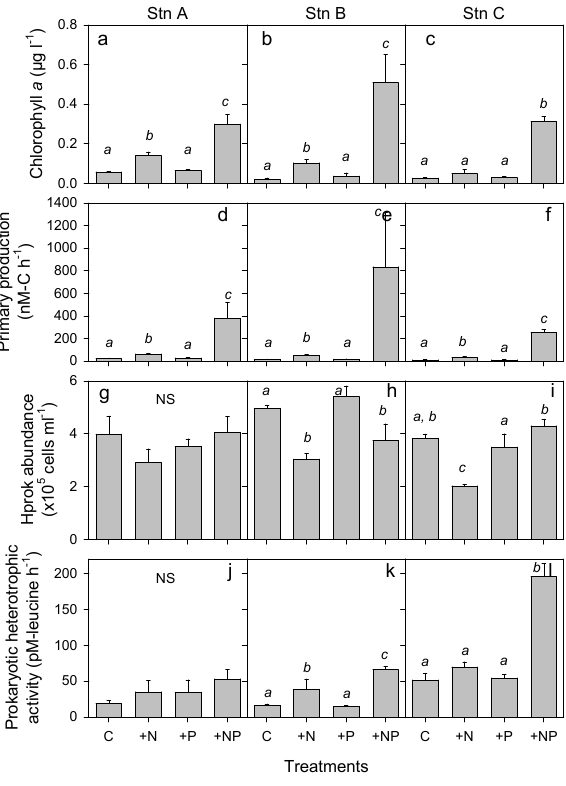
Fig. 4. Comparison of responses of chlorophyll- a (µgl − 1 ) ( a, b, c ), primary production (nM-Ch − 1 ) ( d, e, f ), abundance of het- erotrophic prokaryotes (Hprok) (cellsml − 1 ) ( g, h, i ), and prokary- otic heterotrophic activity (pM-leucineh − 1 ) ( j, k, l ) between the different treatments at the last day of the experiment. Values are shown as mean ± SD. C, +N, +P, and +NP denote Control, NH 4 addition, PO 4 addition, NH 4 +PO 4 addition, respectively. Columns labeled by different italic letters ( a or b) are significantly different at P < 0 . 05. NS denotes no significant effect of different nutrient treatments on the parameter measured. See Materials and methods for